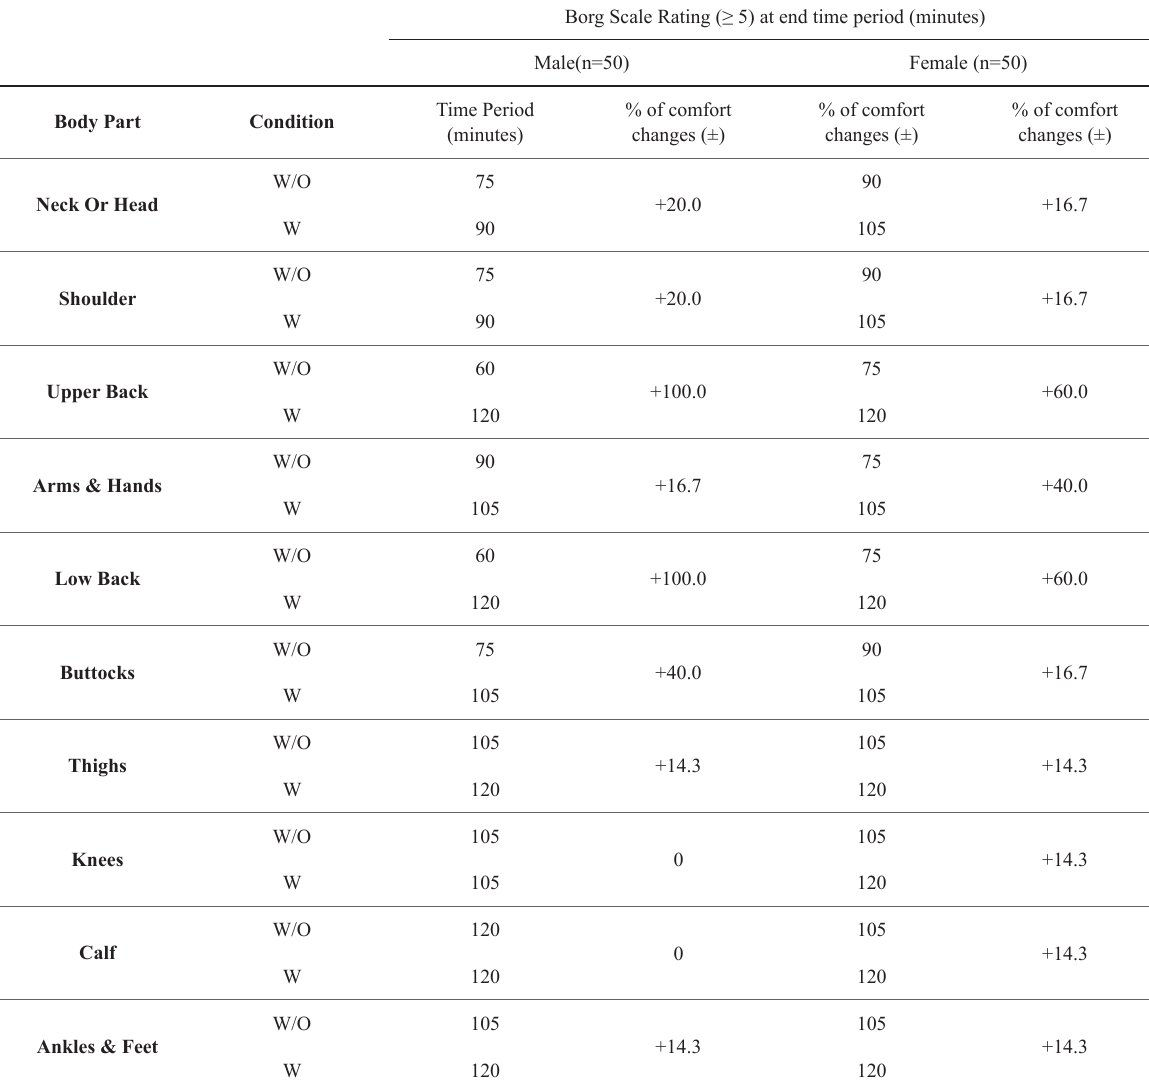
Discomfort ‘Break Point’ data distribution (Borg Scale Rating ≥